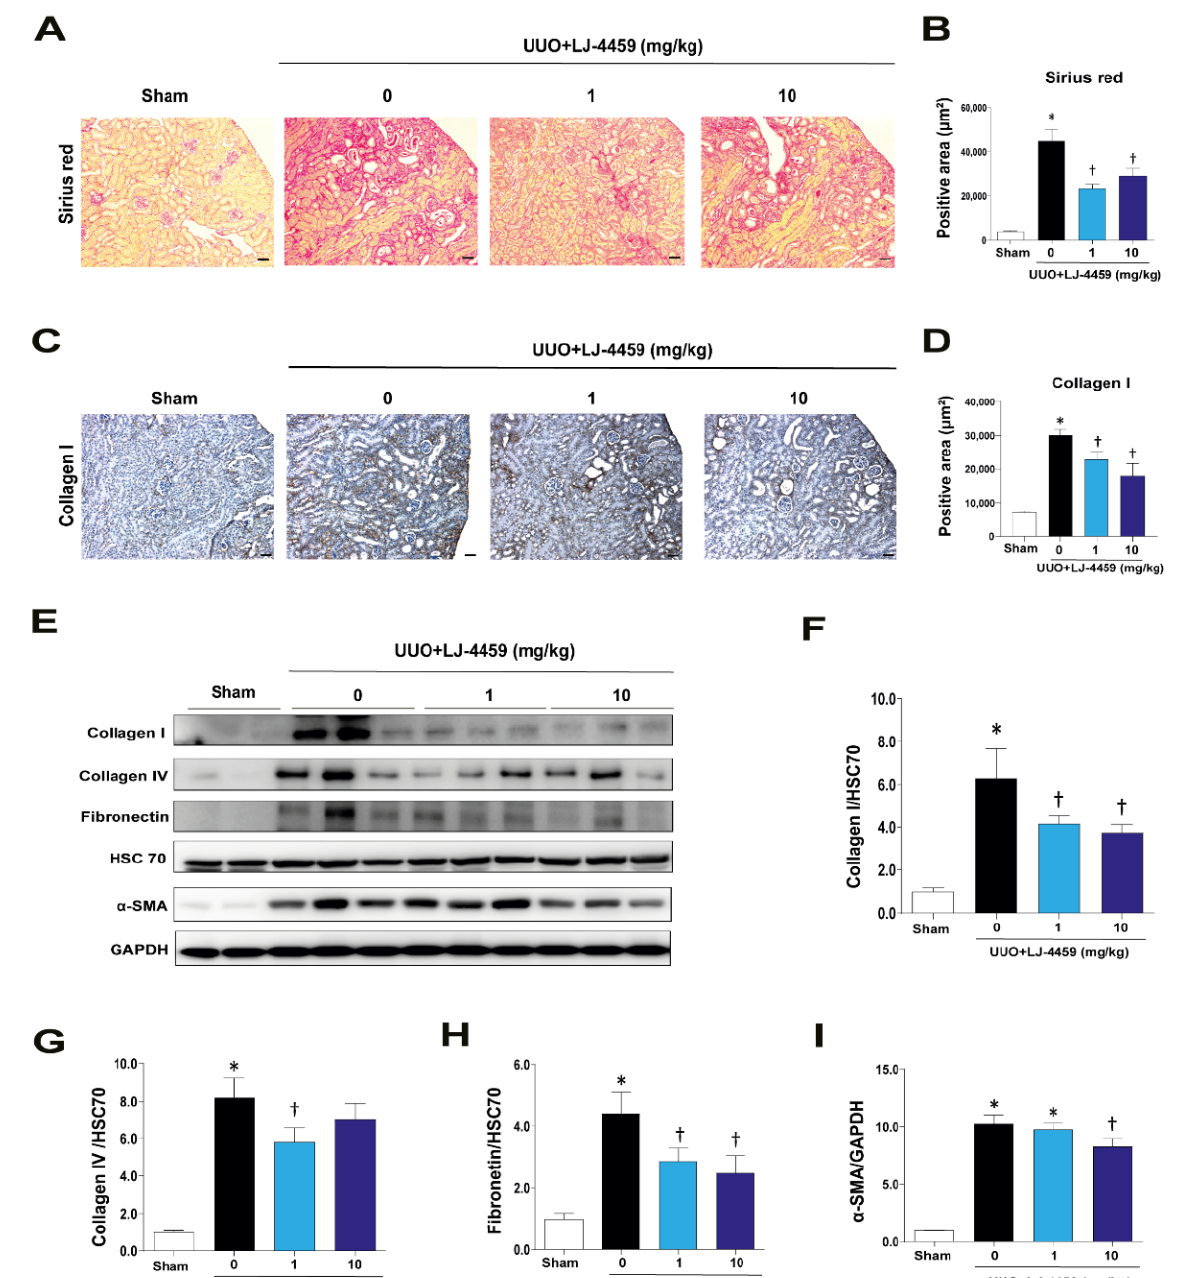
Figure 4. LJ-4459 inhibits kidney fibrosis in UUO mice. Paraffin-embedded kidney sections were stained with ( A , B ) sirius red staining (original magnification: 100 × ; scale bar: 50 µ m) and ( C , D ) anti-collagen I antibody (1:400; original magnification: 100 × ; scale bar: 50 µ m). ( E – I ) Immunoblotting analysis of collagen I, collagen IV, fibronectin, and α -SMA in the kidney. The levels of proteins were normalized with HSC70 or GAPDH. Data are presented as mean ± SE of 7–8 mice. * p < 0.05 vs. sham mice, † p < 0.05 vs. UUO mice.